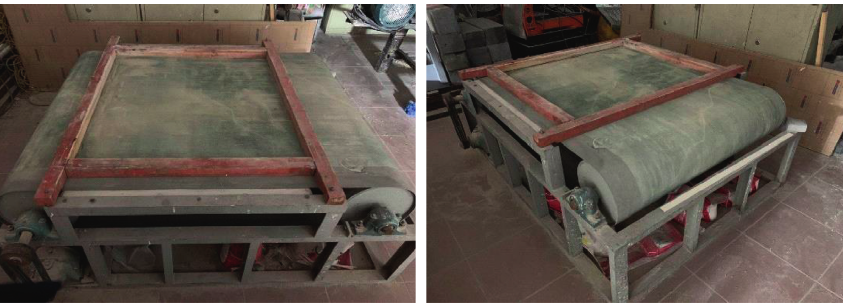
Figure 4: Bottom friction simulation experimental machine.